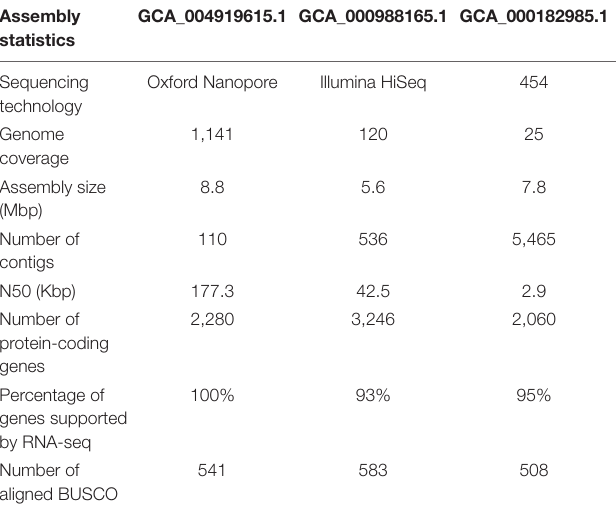
TABLE 1 | Assembly statistics of three versions of N. ceranae